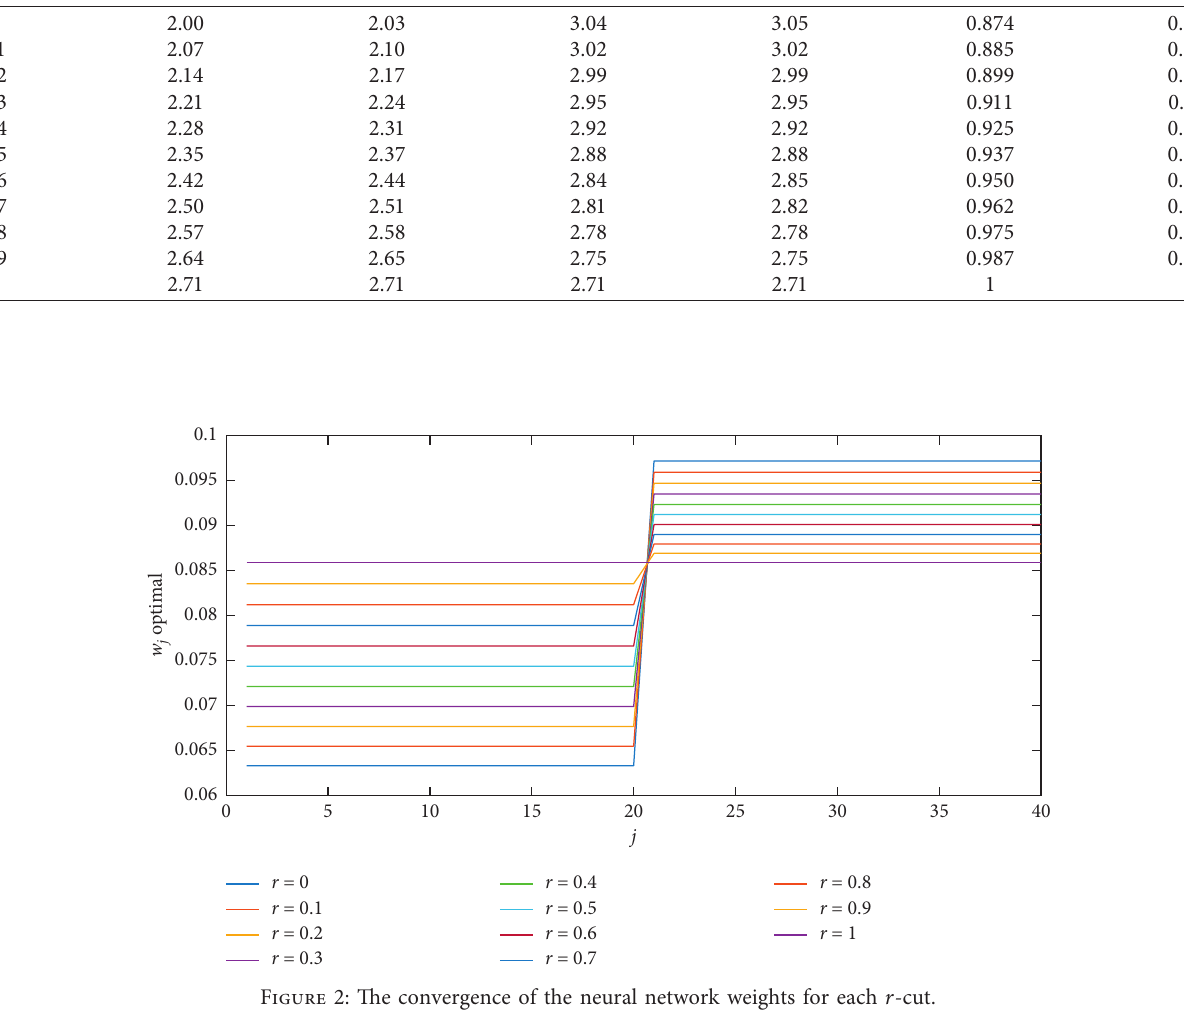
Table 2: Comparison of the exact Z and Z